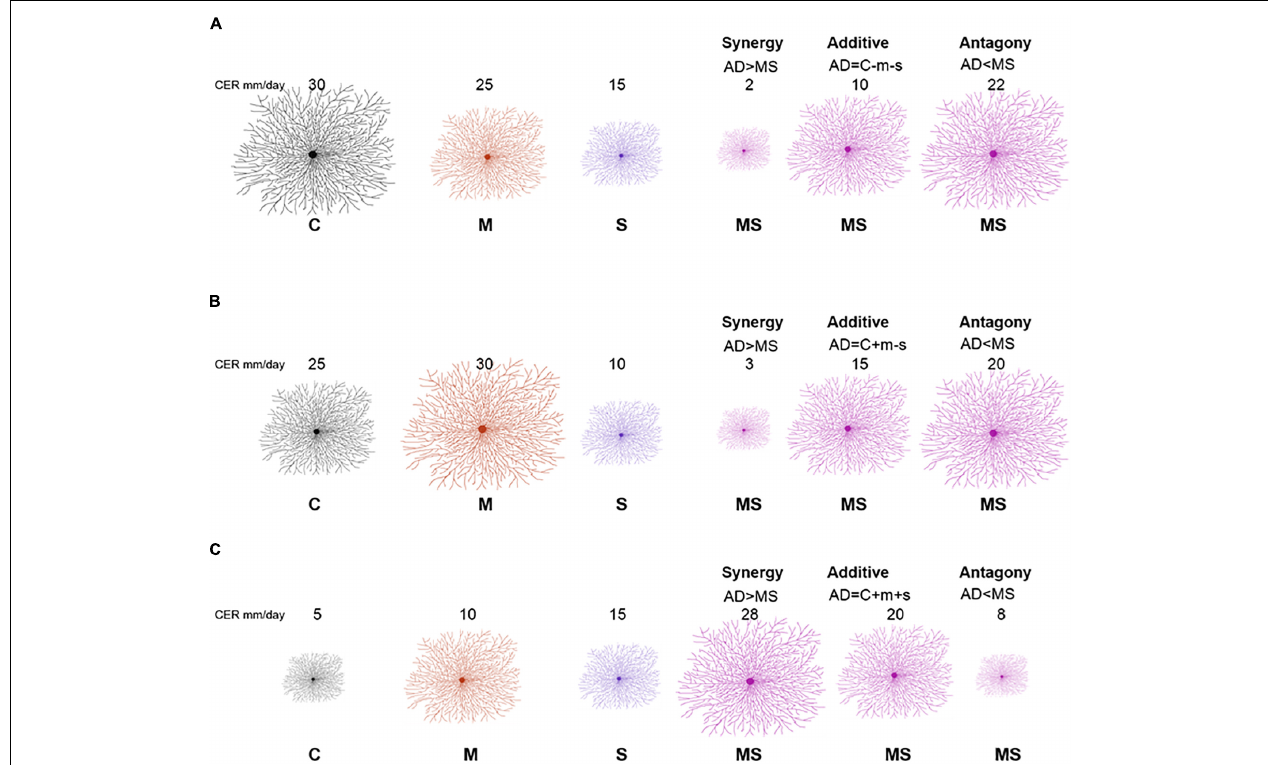
FIGURE 1 | Redrawn from Crain et al. (2008) with adjusted conceptual approach for interpreting interaction types from factorial experiment response data. A full factorial study includes the following treatments: control (C), mild perturbation (M), strong perturbation (S) and both (MS). The three panels illustrate different combinations of individual responses: double negative (A) , opposing (B) , and double positive (C) . The numbers indicate example values of colony extension rate (proportional to the size of the mycelium). Interaction types (synergy, additive, and antagony) depend on MS response in comparison with the sum (AD) of individual responses of single perturbations ( m = C − M ; s = C − S